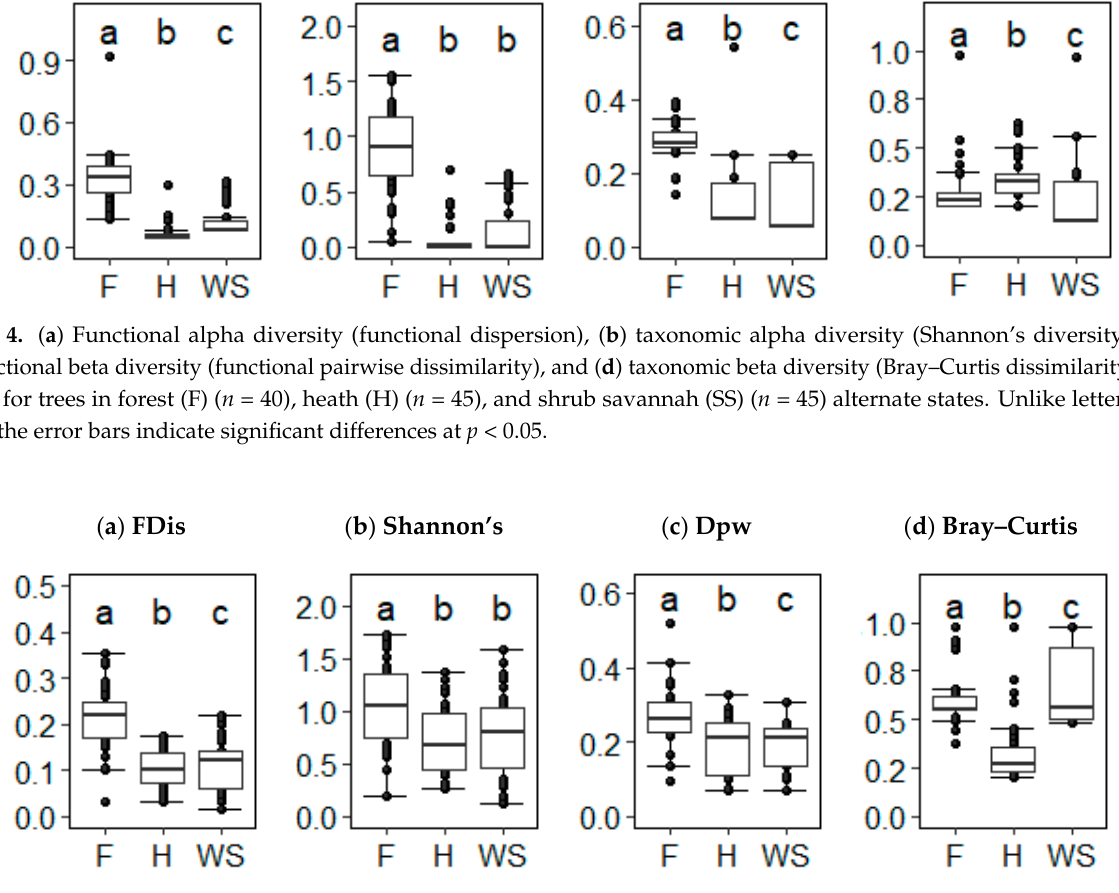
Figure 4. ( a ) Functional alpha diversity (functional dispersion), ( b ) taxonomic alpha diversity (Shannon’s diversity), ( c ) functional beta diversity (functional pairwise dissimilarity), and ( d ) taxonomic beta diversity (Bray–Curtis dissimilarity) values for trees in forest (F) ( n = 40), heath (H) ( n = 45), and wood savannah (WS) ( n = 45) alternate states. Unlike letters above the error bars indicate significant differences at p < 0.05.